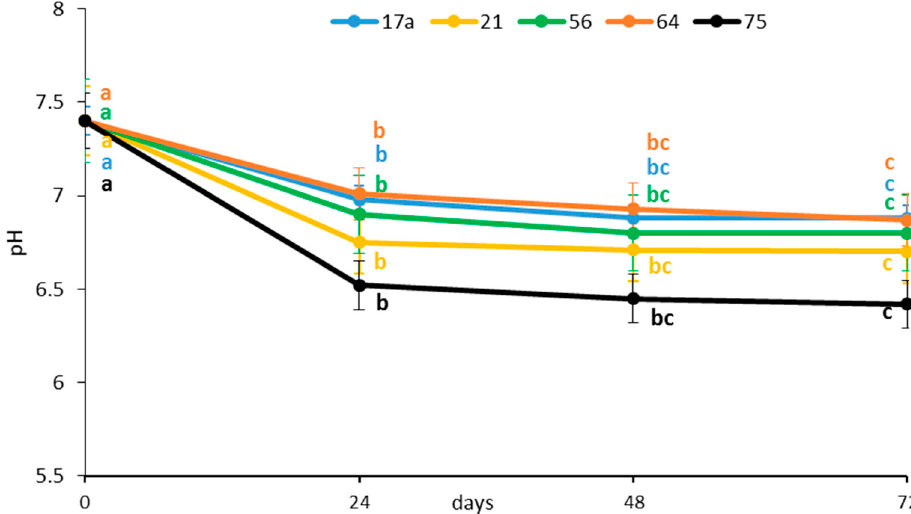
Figure 2. Influence of lactic acid fermentation with different LAB strains on total soluble solids of the brine solution of African nightshade ( Solanum retroflexum) leaves. Each value represents the mean value of three replicate samples. Means followed by the same letter within a series are not significantly different ( p < 0.05).